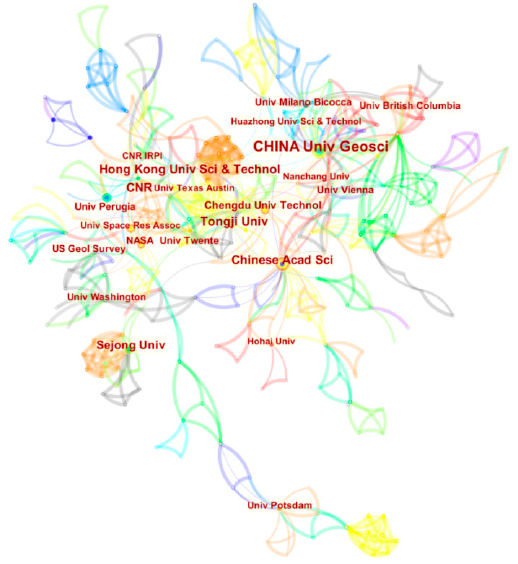
Figure 8. Institutional cooperation network knowledge graph.